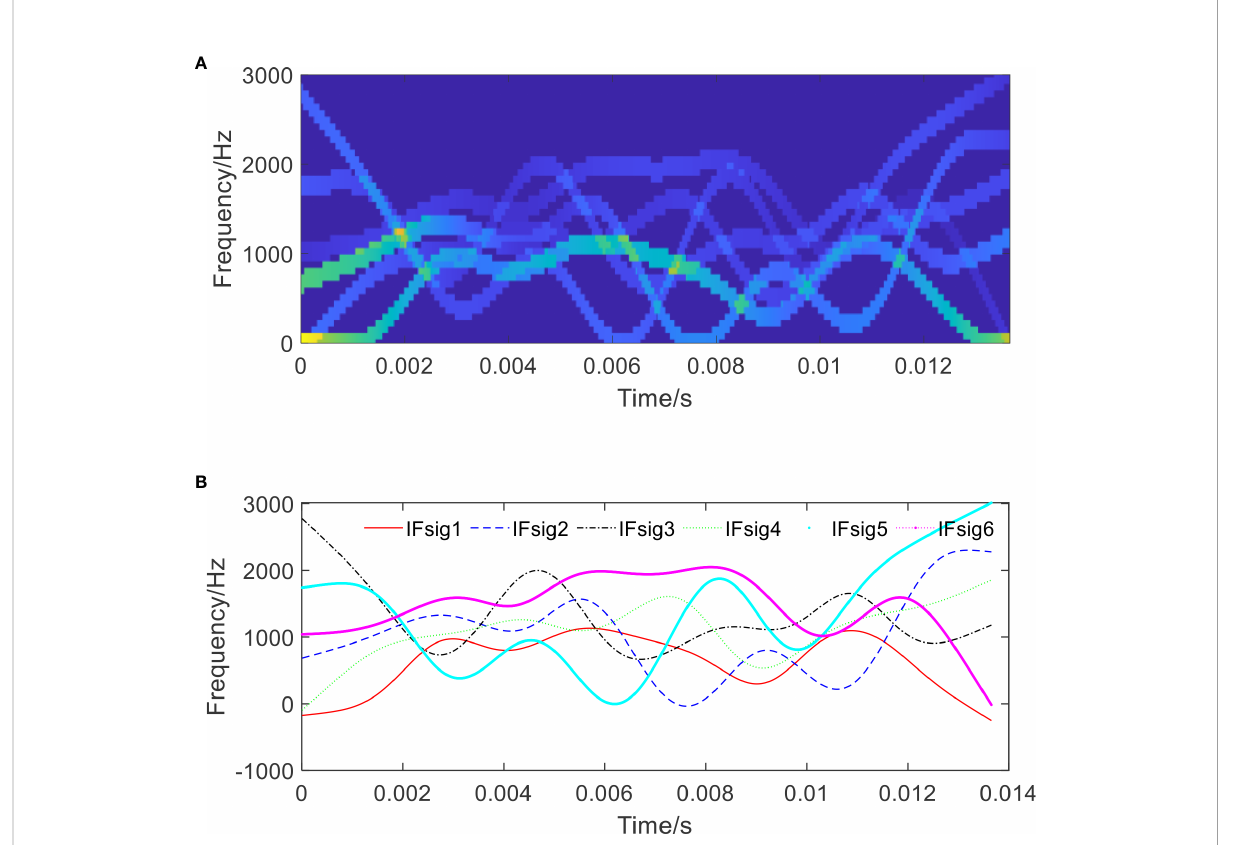
FIGURE 13 The TF diagram and IF plot of the estimated components using the ACMD method. (A) The TF diagram of the estimated components; and (B) the IF plot of the estimated